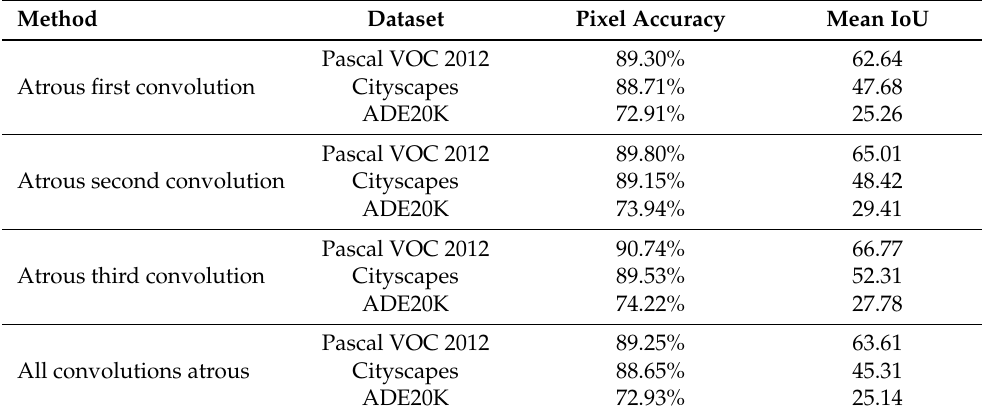
Table 13. Results obtained by dilating convolution from each module from the middle flow in four different